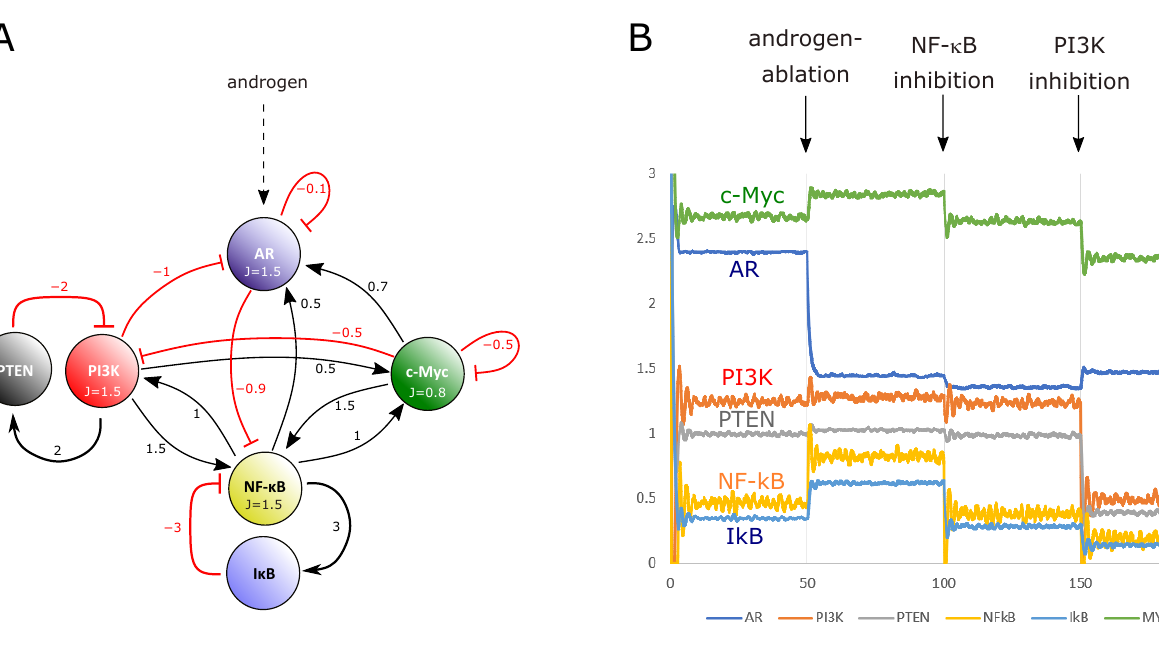
Figure 9. Mathematical simulation of a dynamic network between AR, NF- κ B/I κ B, and c-Myc. ( A ) Interdependent network between AR, NF- κ B/I κ B, PI3K/PTEN, and c-Myc with estimated activating or inhibitory links as indicated by the numbers of lines linking the nodes. The presence of androgens provides a stimulatory effect on AR. ( B ) Time course of activities (arbitrary units) as predicted by the model. Loss of androgens or inhibition of AR (androgen-ablation arrow) leads to upregulation of NF- κ B and c-Myc activities, while subsequent inhibition of NF- κ B and PI3K results in a downregulation of c-Myc activity below the original